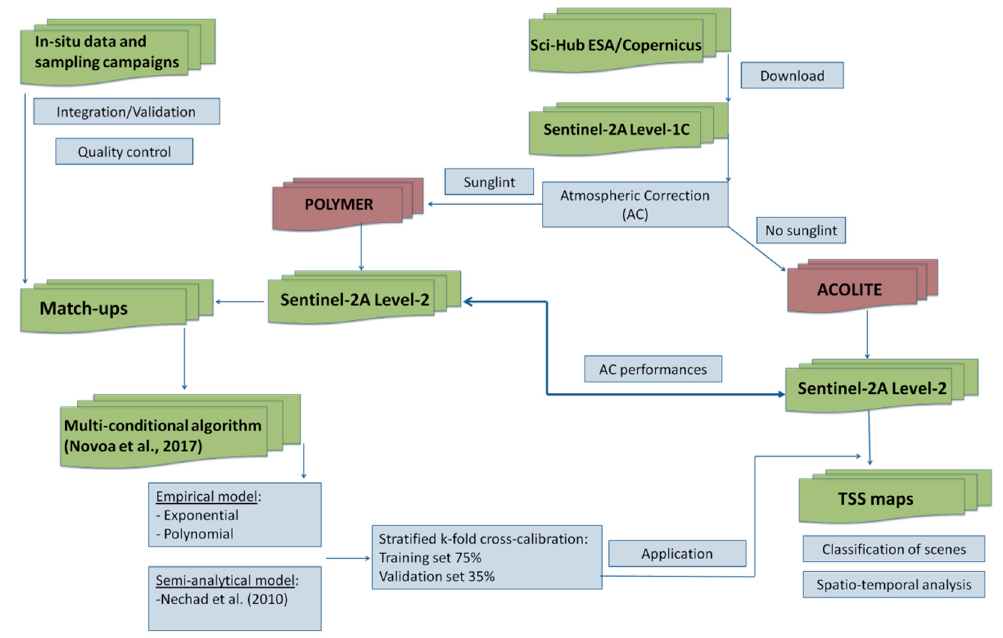
Figure 2. Schematic flow chart of the satellite image processing system describing the Total Suspended Solids (TSS) sampling, the Atmospheric Correction (AC), the multi-conditional algorithm using the red and near-infrared (NIR) bands, and the cross-validation procedure.